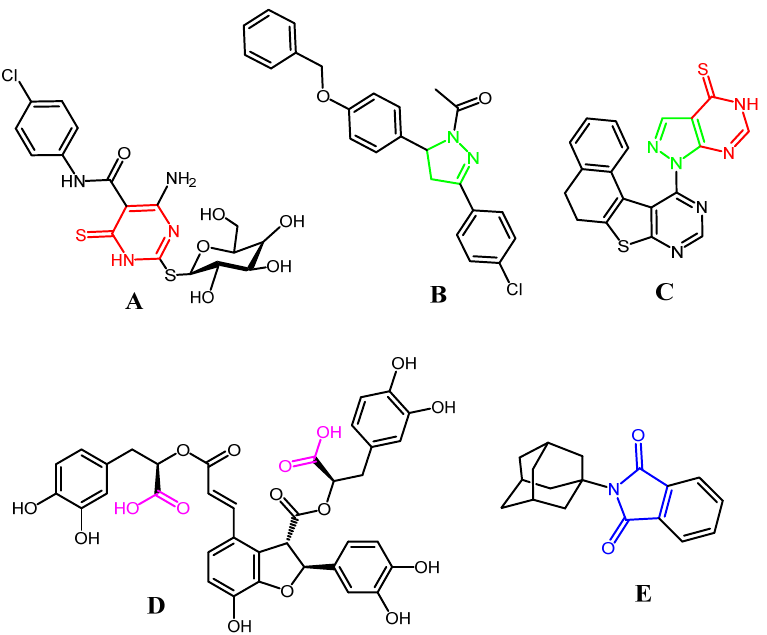
Figure 1. Previously reported antiviral compounds ( A – E ).